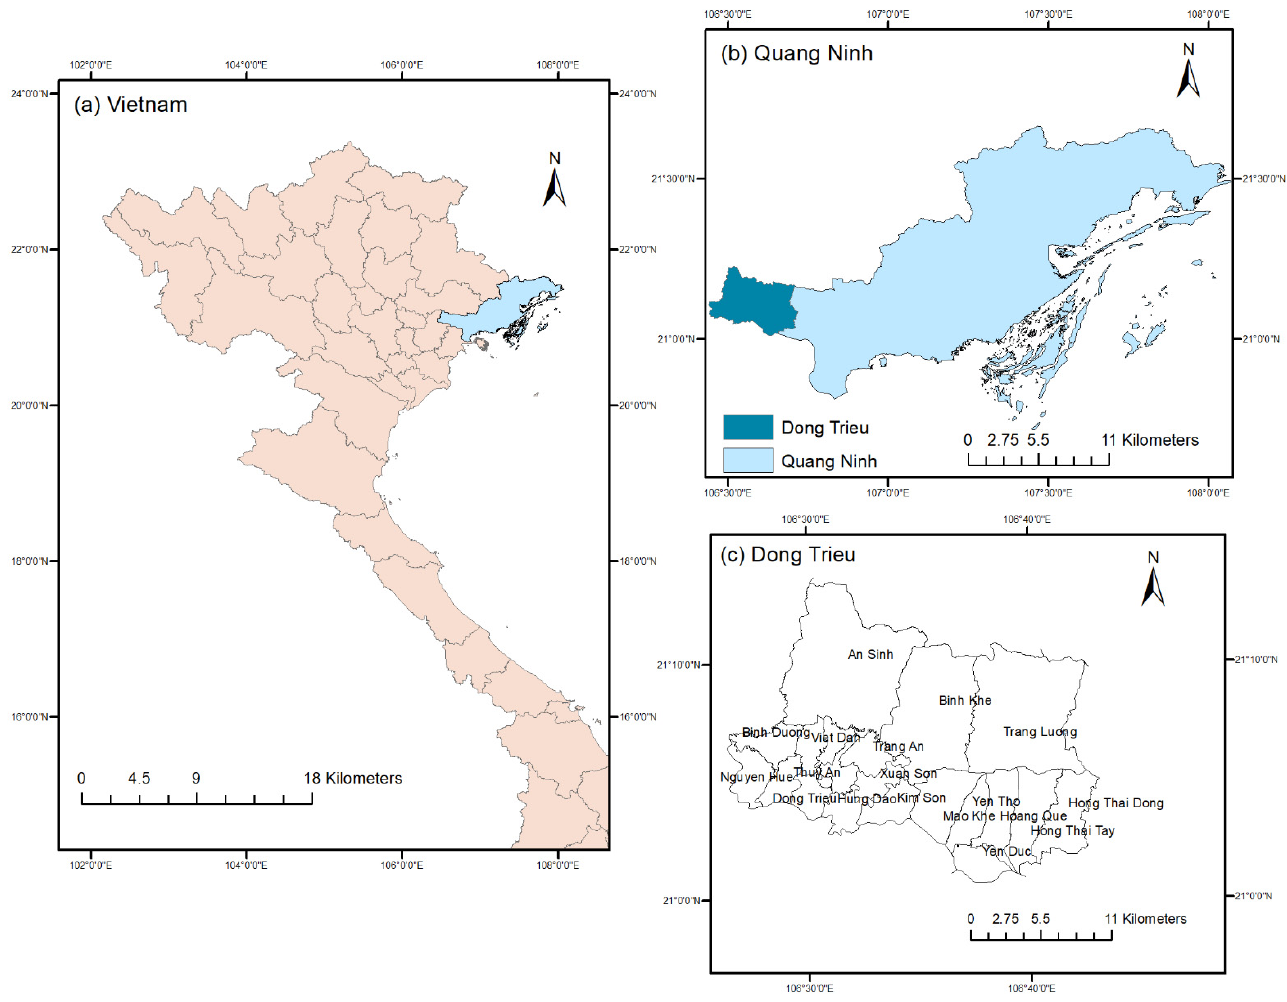
Figure 2. Location maps of the study area.